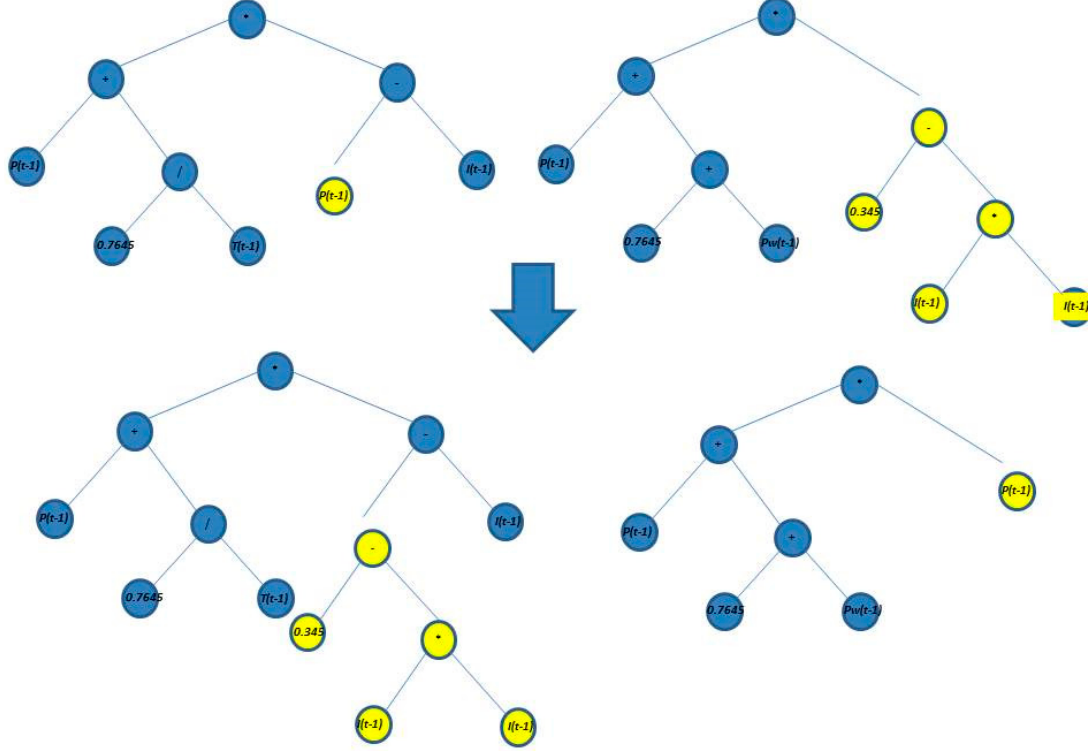
Figure 5. Crossover process in the GP to forecast the scale parameter.